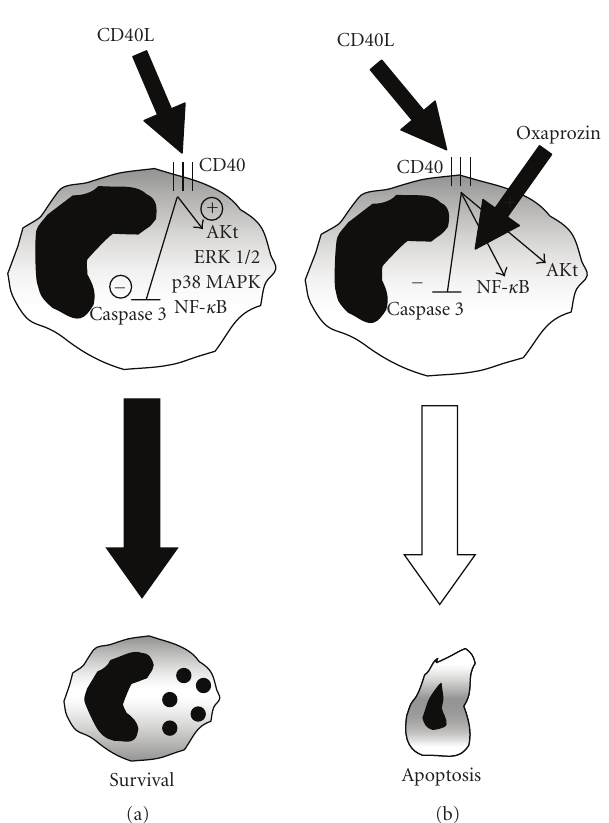
Figure 5: (a) CD40L-induced monocyte survival is associated with Akt, ERK 1/2, P38 MAPK and NF- κ B activation, and caspase 3 inhibition. (b) Oxaprozin-induced apoptosis in CD40L-treated monocytes is associated with the inhibition of Akt and NF- κ B and the activation of caspase 3